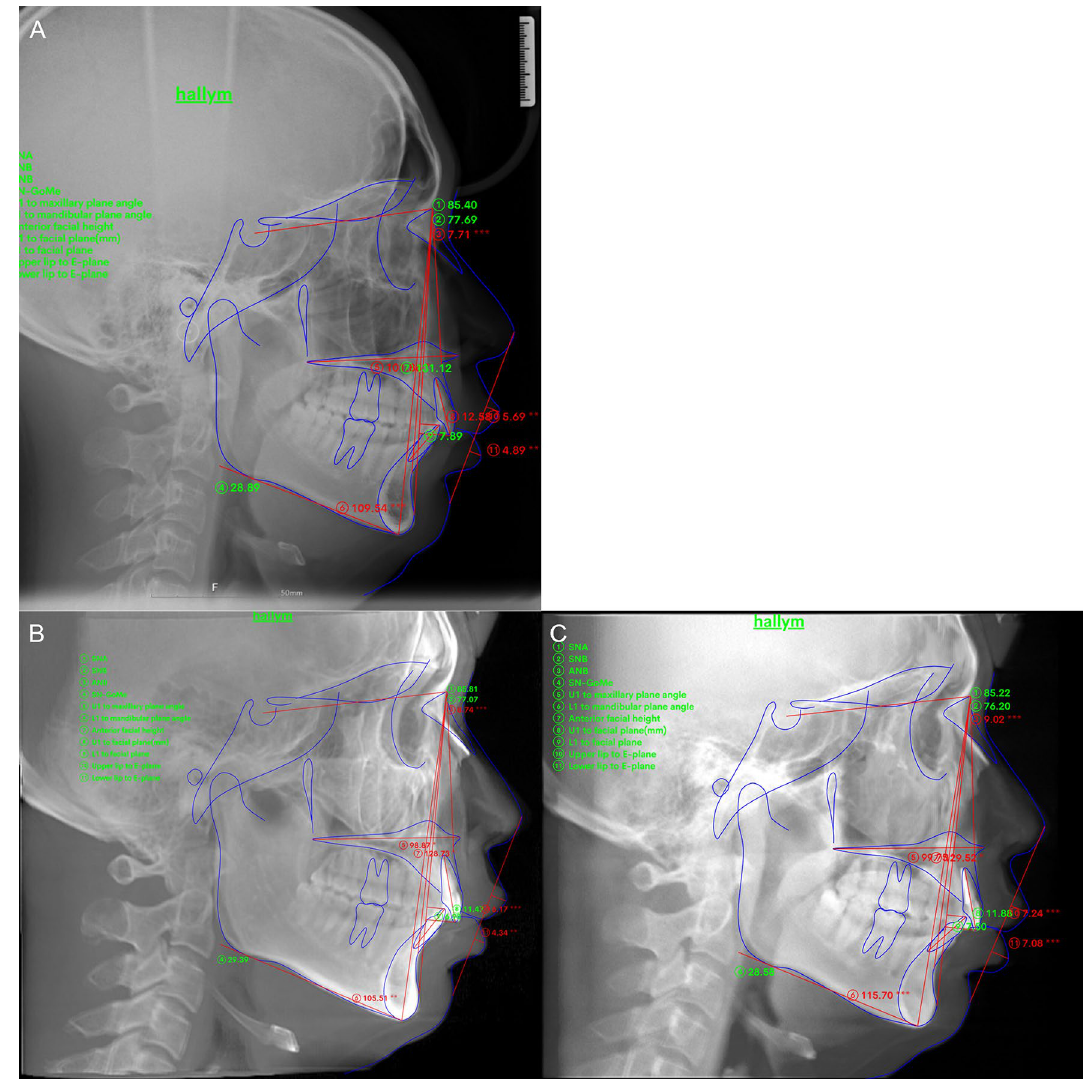
Figure 1. Measurements used in this study. ( A ) Conventional lateral cephalogram, ( B ) lateral cephalogram generated from OnDemand 3D, and ( C ) lateral cephalogram generated from Invivo5.